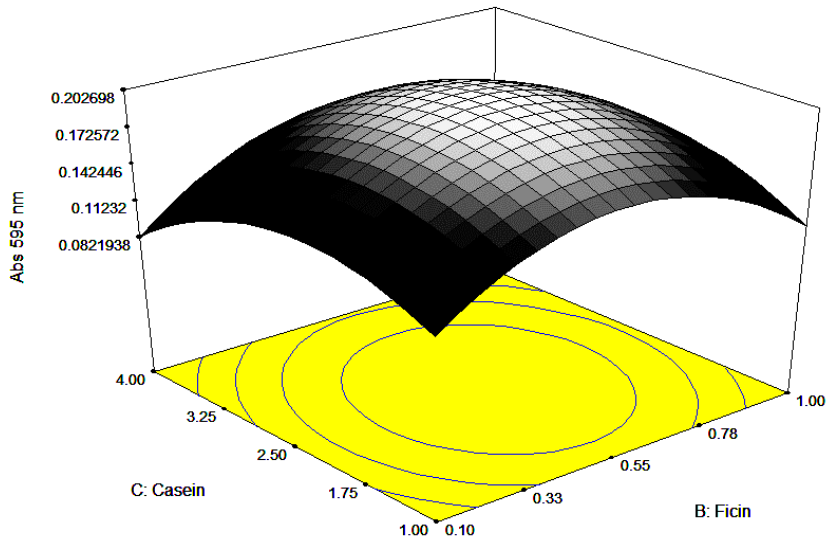
Figure 8. Here, 3D surface response view showing the response when ficin and casein concentrations were varied .